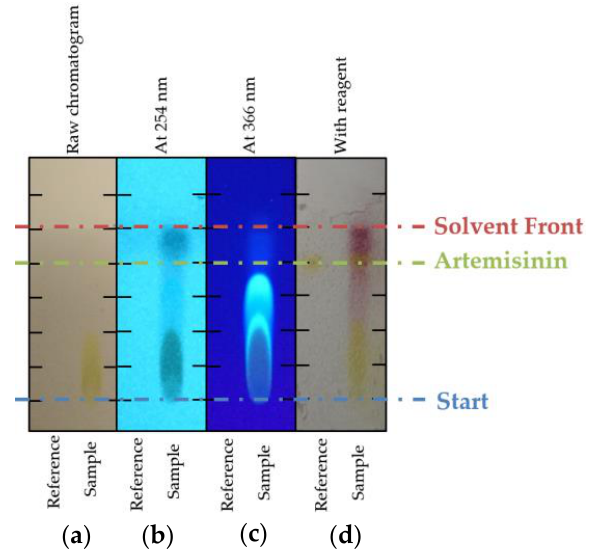
Figure 5. Evaluation of the TLC plates using the example of methanol/isopropyl alcohol (30/70). On the left side of the plate is a standard artemisinin solution; on the right side is the extract sample. In part ( a ) is the normal chromatogram, in part ( b ) is the chromatogram under ultra violet (UV) light (at 254 nm), in part ( c ) under 366 nm, and part ( d ) after treatment with vanillin–phosphoric acid reagent.